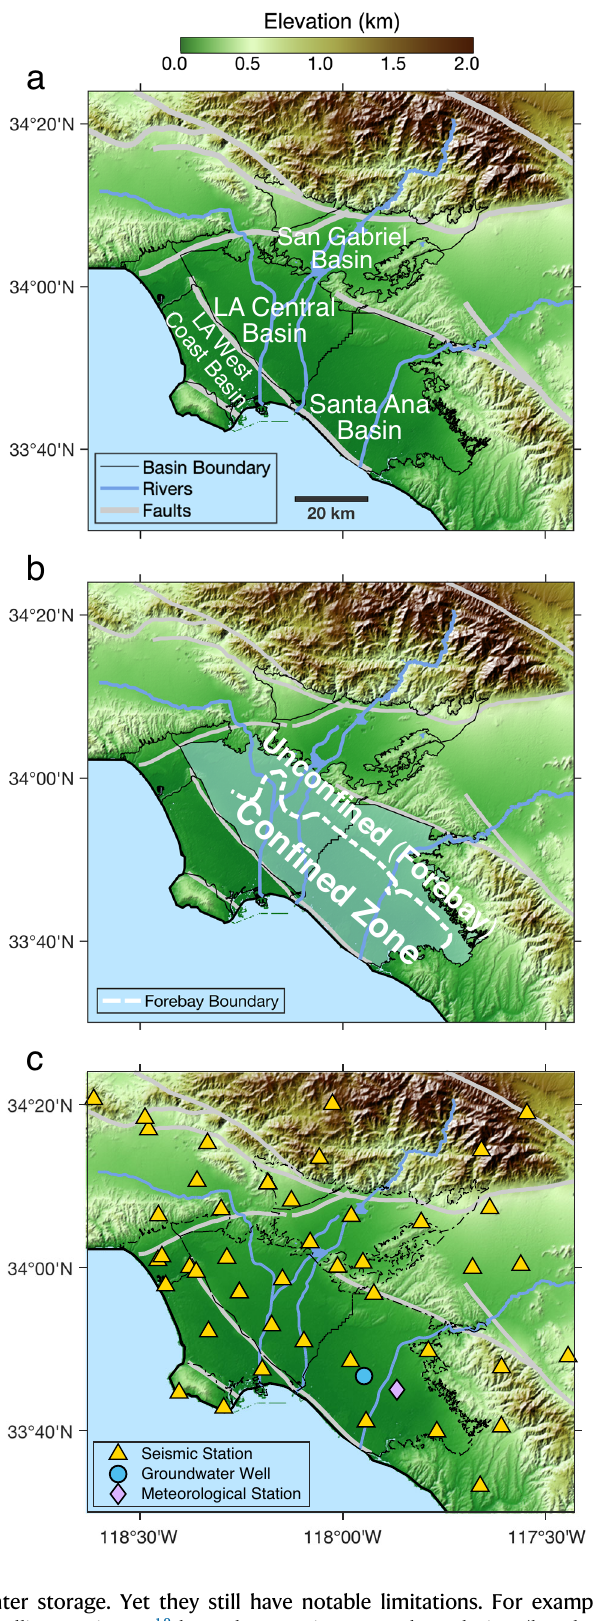
Fig. 1 | Hydrogeological settings and station locations in the study area. a Groundwater basins near Los Angeles, California (adjudicated to different local water departments). Primary basins studied in this paper include the San Gabriel Basin, the Los Angeles (LA) Central Basin, the Santa Ana Basin, and the LA West Coast Basin. b The uncon fi ned (forebay) and con fi ned zones in LA Central and Santa Ana basins. The forebay boundary is estimated by the Orange County Water District (OCWD) 45 and the Water Replenishment District (WRD) of Southern California 46 . Con fi ned to semi-con fi ned conditions also exist in the San Gabriel Basin. c Station locations. Yellow triangles denote the broadband, 3-component seismic stations in the CI network operated by the Southern California Earthquake Data Center (SCEDC) available from 2000 to 2020. The blue circle denotes the groundwater monitoring well GGM-1/MP1 operated by OCWD, from which the hydraulic head data are shown in Fig. 2b. The violet diamond denotes the meteorological station ANA at which the precipitation record is shown in Fig.